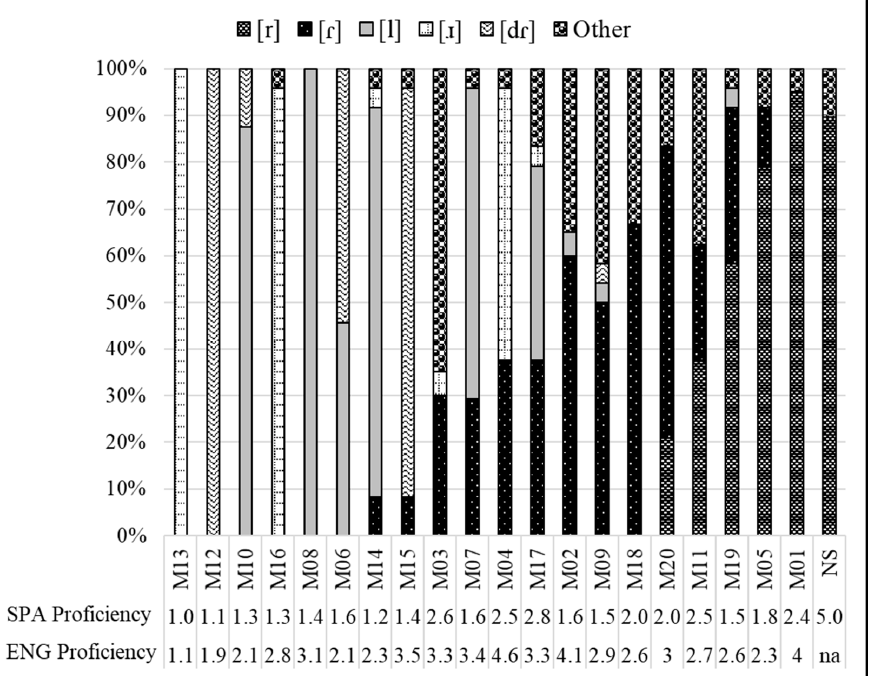
Figure 4. Percentage realization of each segment for the Spanish trill target, as produced by Mandarin L3 learners of Spanish (M01–M20) and native Spanish speakers (NS; average results presented in the final column). Results are ordered by percent accuracy of trill production, from lowest to highest.